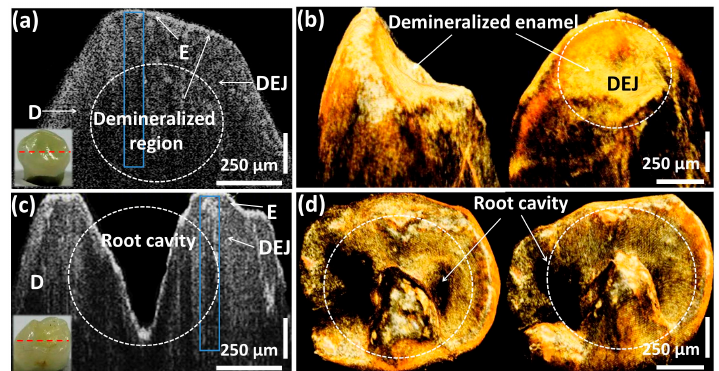
Figure 6a. In the A-scan profile, the blue solid line, black dashed line, and green dotted line represent the A-scan depth profiles of healthy sample, canine sample, and pre-molar sample, respectively. Similar signal intensity behavior was confirmed as before, owing to the low scattering coefficient of partially demineralized samples, which confirms the changes of the sample composition compared to the healthy sample. Then, we analyzed and compared the total intensity fluctuation of both partially demineralized samples according to each imaging depth range (Figure 6b).